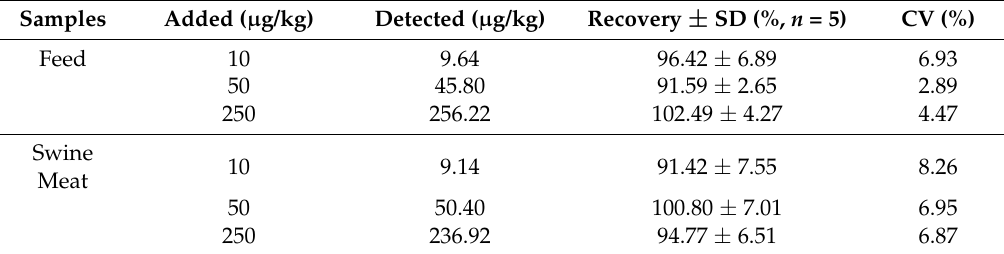
Table 2. Recovery of T-2 from spiked samples when tested using